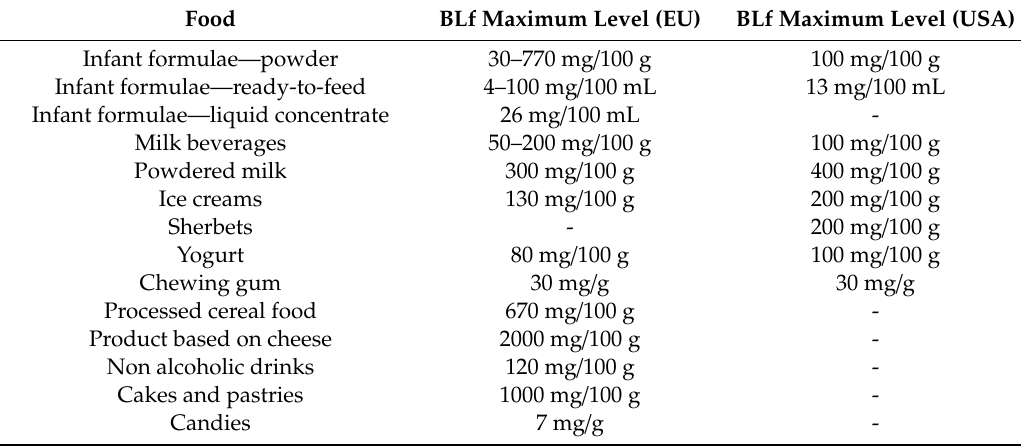
Table 2. Maximum intended use levels of bovine lactoferrin in supplemented foods